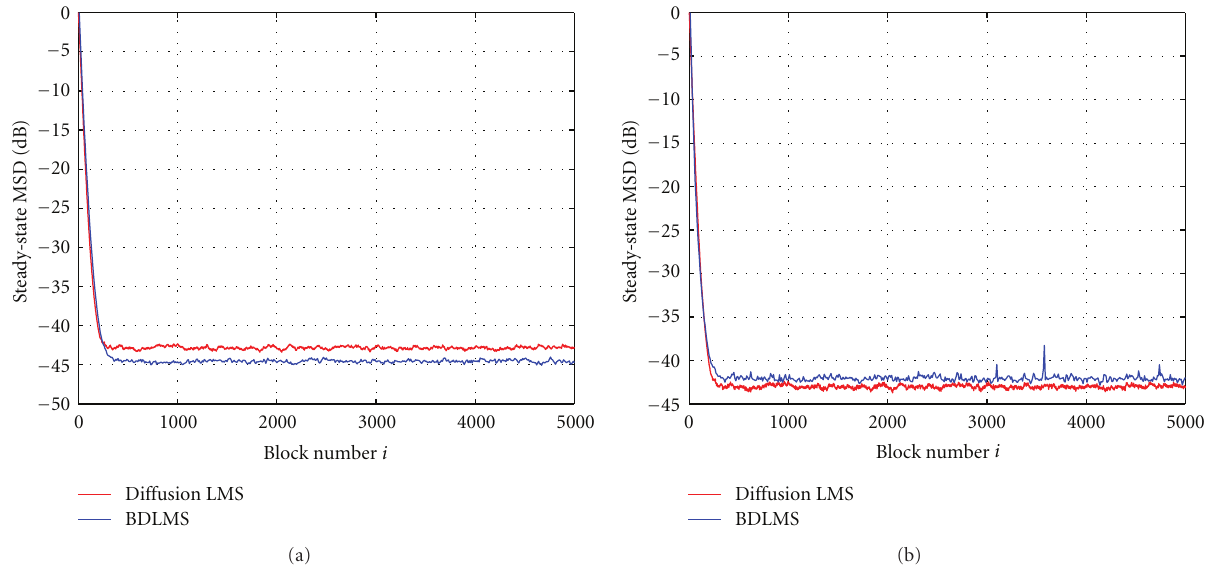
Figure 6: Local mean-square deviation (MSD) comparison between block di ff usion LMS and di ff usion LMS. (a) MSD curve at node 1. (b) MSD curve at node 7.